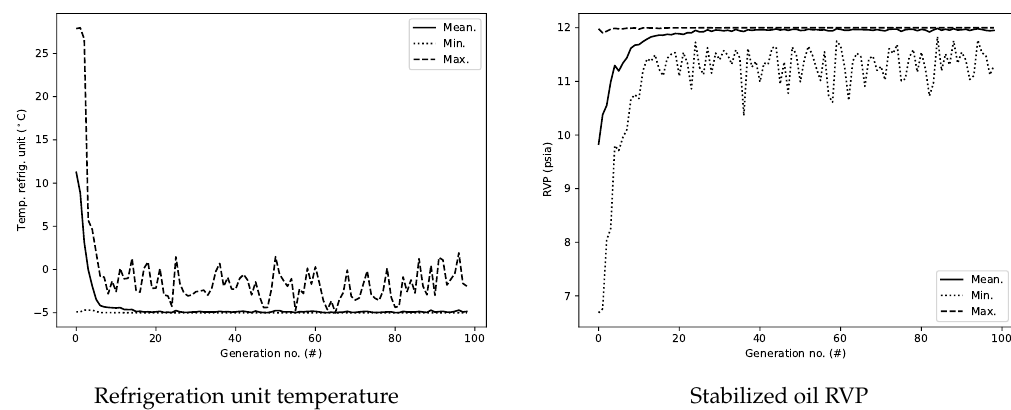
Figure 5. Convergence of variables and constraint function as a function of generation number for surrogate models with the NSGA-II algorithm.